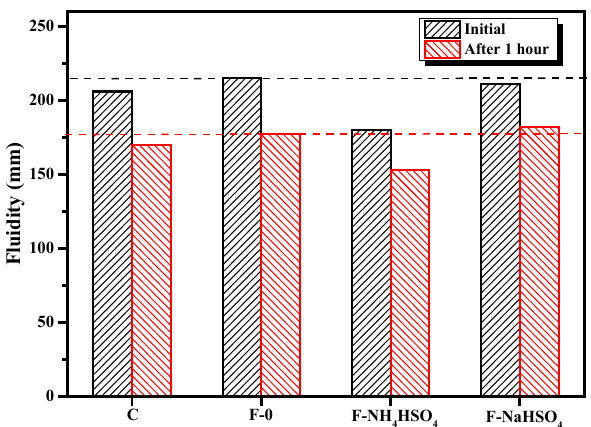
Figure 1. Effect of different sulfates on the fluidity of fly ash cement